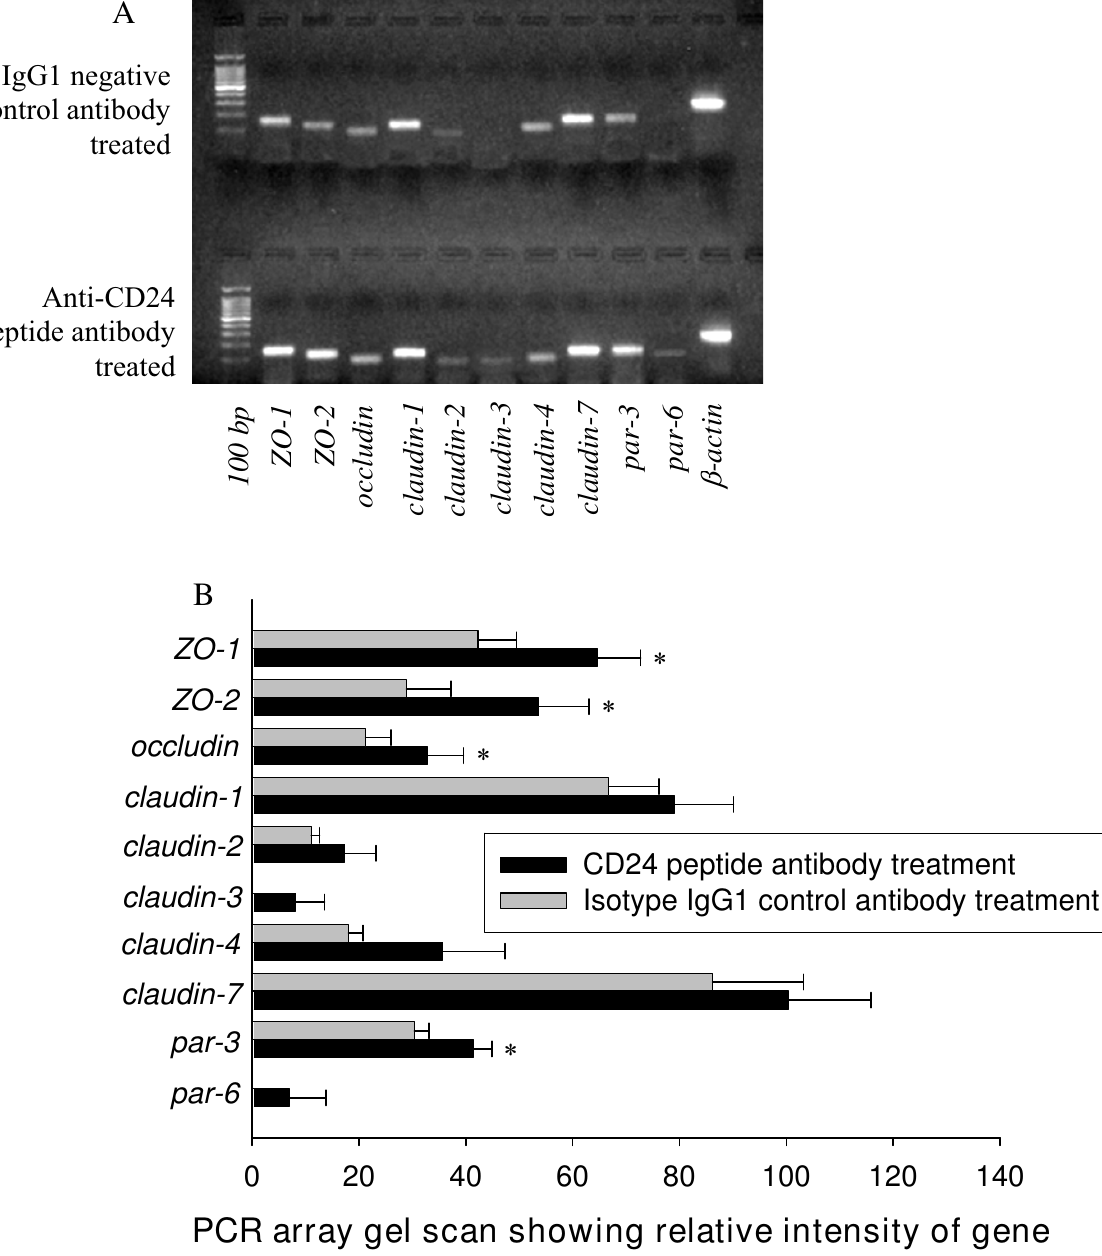
Figure 2 (see legend on next